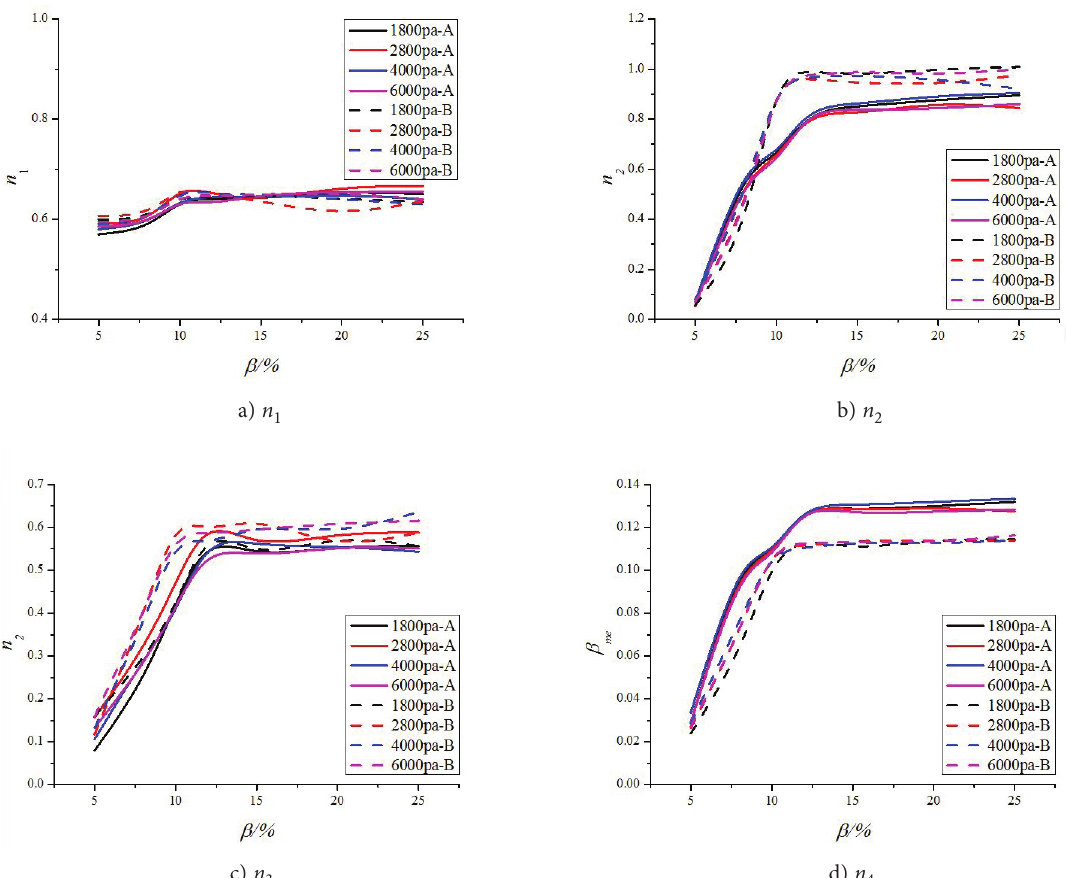
Figure 6. Numerical results of parameters in the empirical formula (Eq.